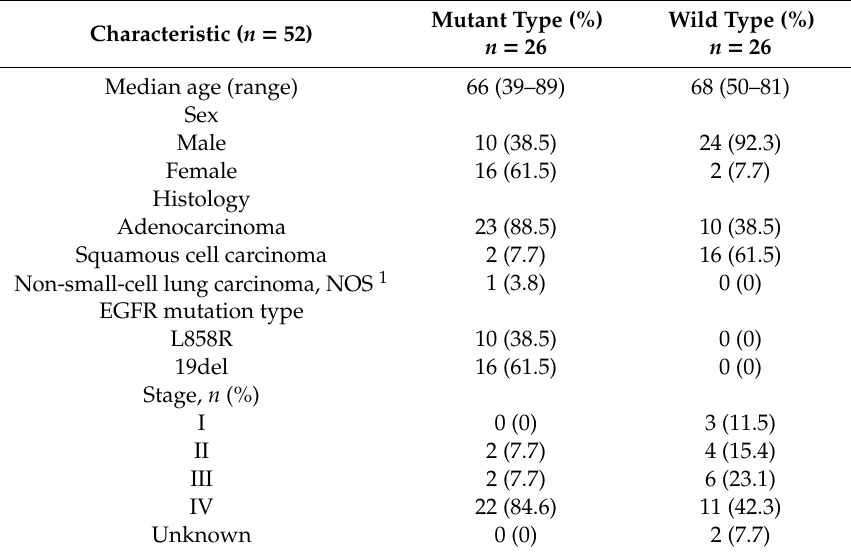
Table 1. Patient’s clinical and pathological